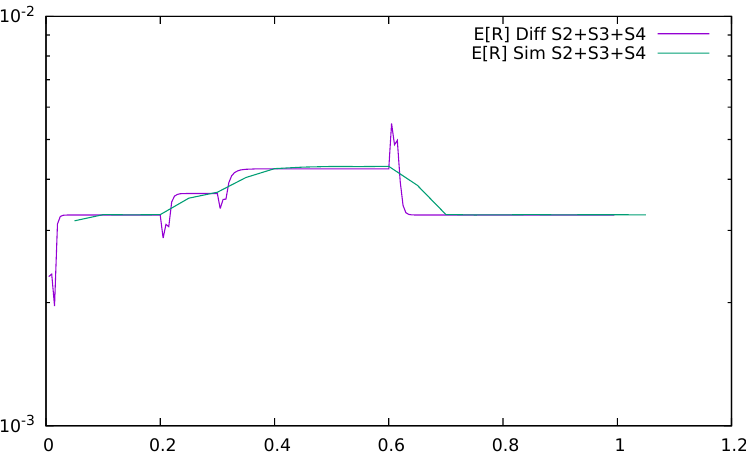
Figure 27. Mean delay introduced by the communication with the controller as a function of time, (cid:101) = 0.2, diffusion, and simulation results.